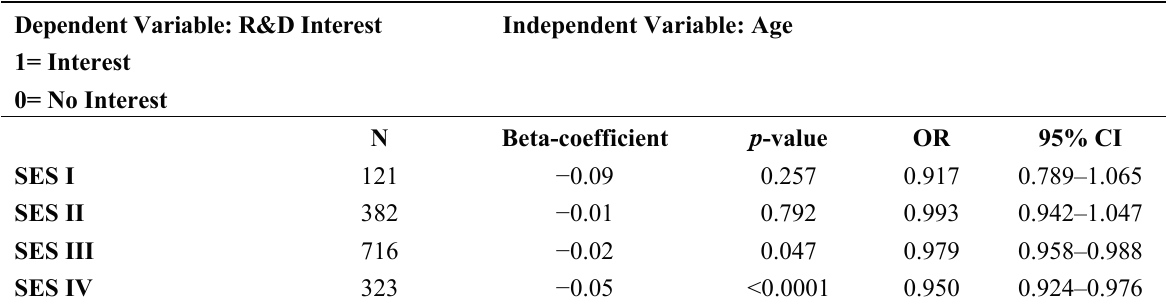
Table 3. The influence of the variable age on R&D interest in four separate SES groups.